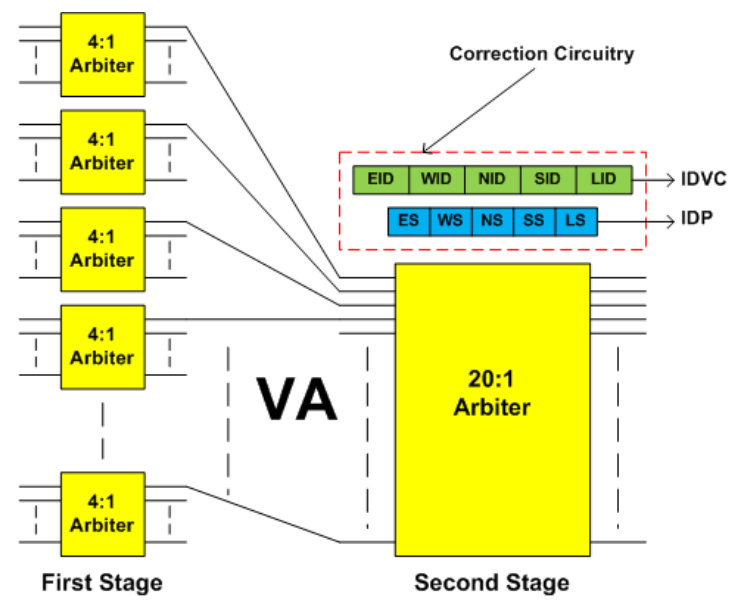
Figure 5. Fault-Tolerant VA Unit Design.